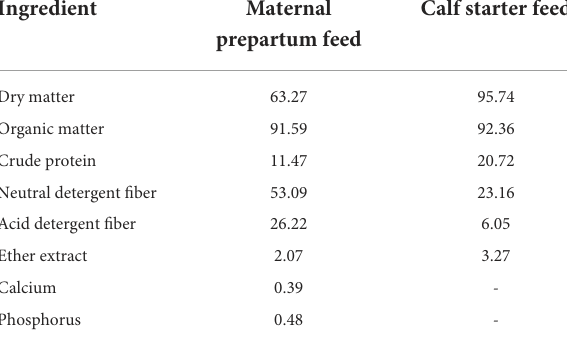
TABLE 1 Nutrient composition (% dry matter) of maternal prepartum diet and calves starter feed.